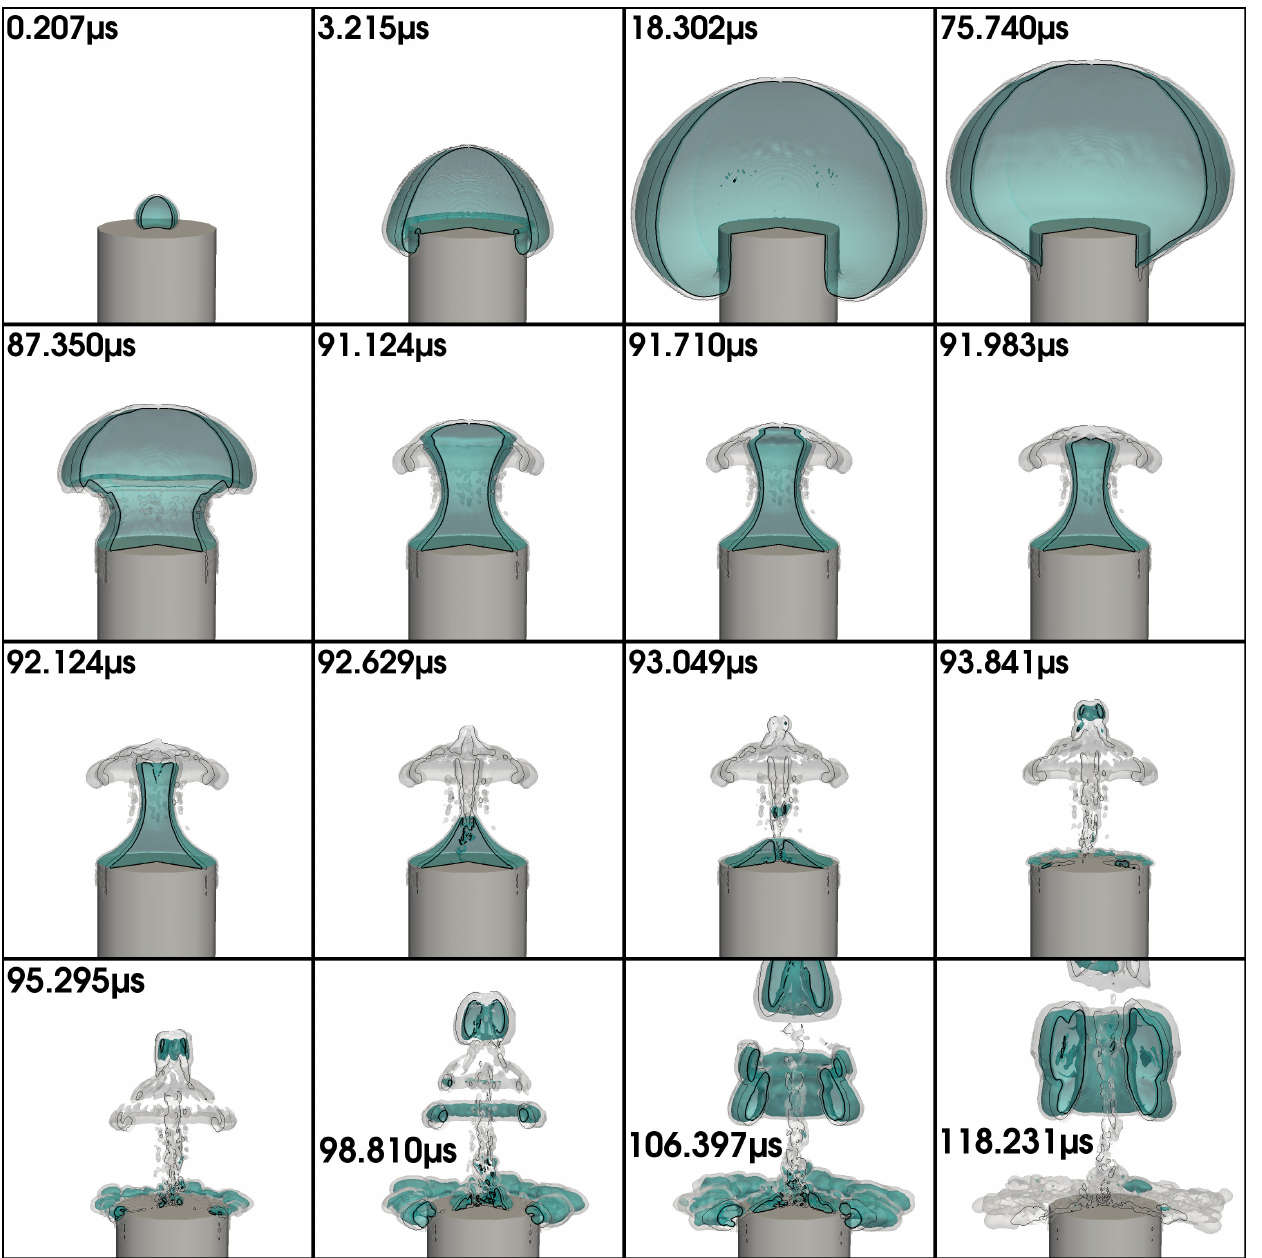
Figure 16. Full 3D simulation for D ∗ = 0.057, r ∗ p = 0.382 (large overlap of the bubble over the pillar rim), showing the “mushroom dynamics” including the projectile. Cylinder radius is 200µm. The quarter volume of the bubble pointing to the front has been cut out for visualizing the bubble shape by a black contour line with the fast jet inside, first to be seen at 92.124 µs. The liquid is the white background for best visualization of the bubble and its